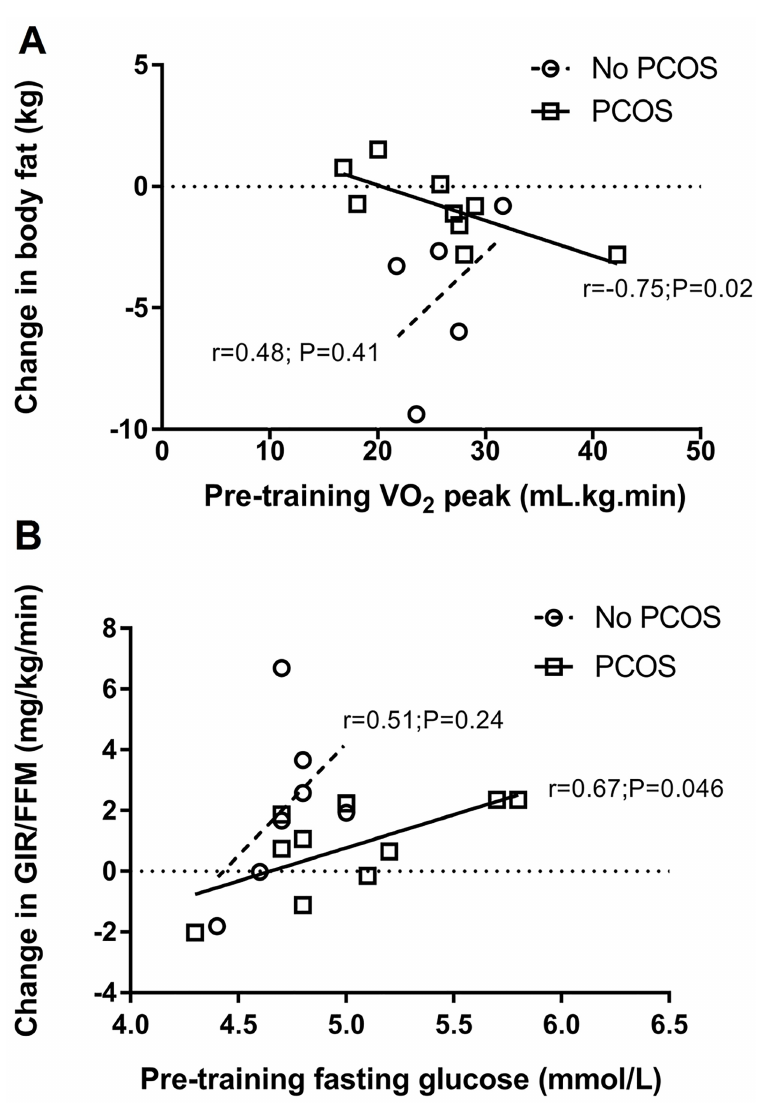
Fig 3. Pearson correlations for associations of baseline VO2 peak with change in body fat (A) and for baseline fasting glucose with change in GIR/FFM (B) according to PCOS status.